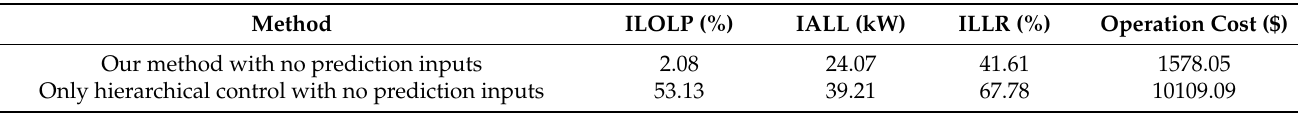
Table 4. Performances of our methods in an extreme